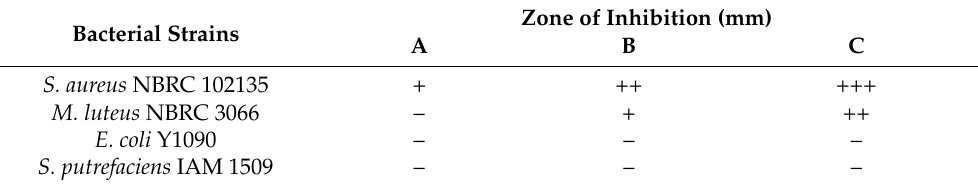
Table 1. Antibacterial activity of KSHPH. Bacterial Strains